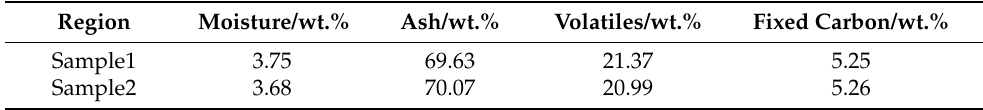
Table 2. Fisher analysis of Fuyu oil shale. Region Shale Oil/wt.%